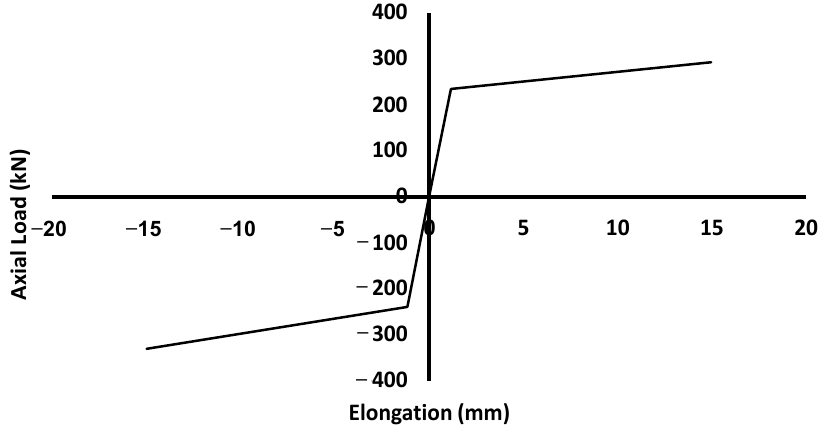
Figure 4. Load deformation relationship adopted for modeling BRB1 based on previous test results [39] .